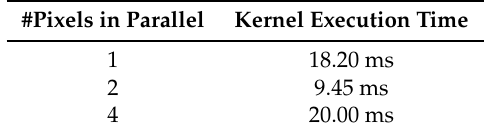
Table 8. Kernel execution times when processing a different number of pixels in